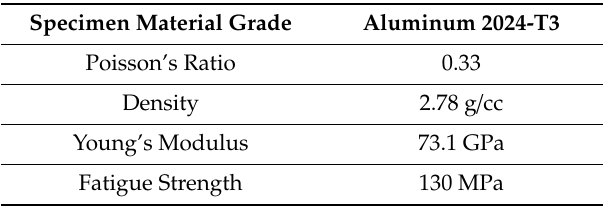
Figure 7. The sensors network design of testing specimen ( a ) diagram (mm) ( b ) the real layout.